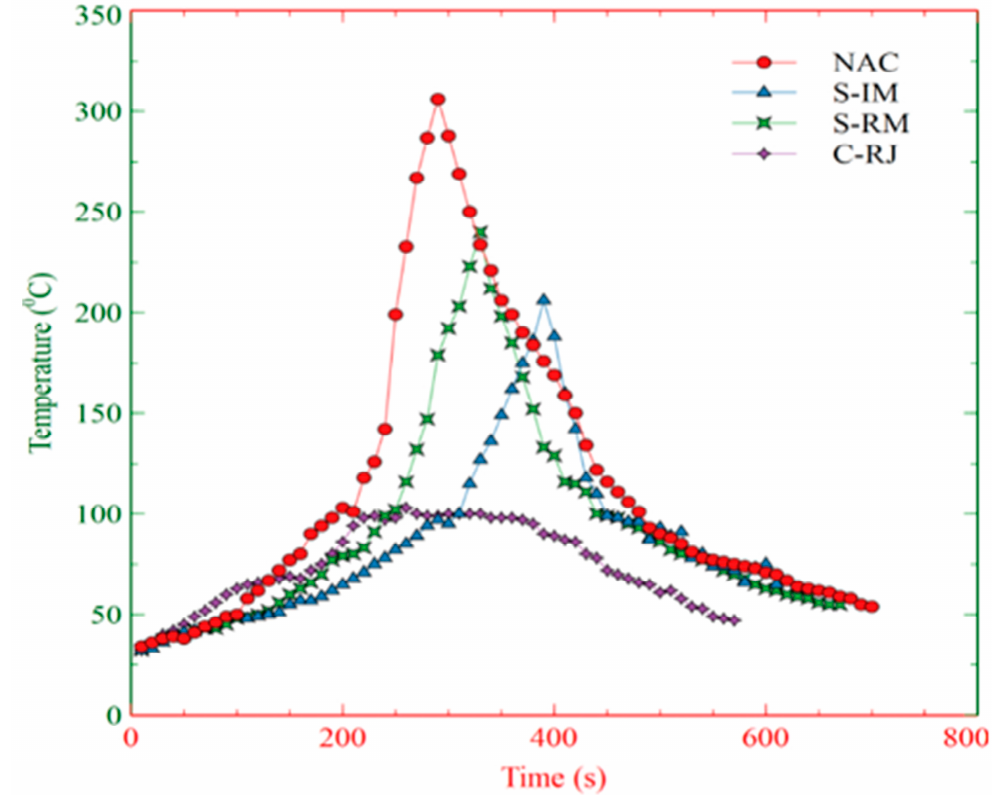
Figure 4. Welding thermal cycle for different cooling